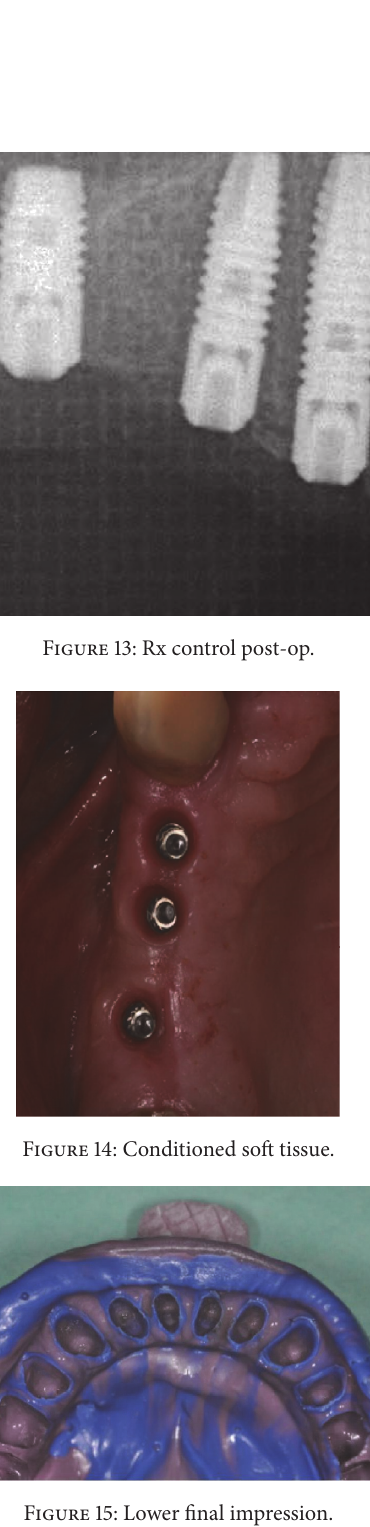
Figure 15: Lower final impression.